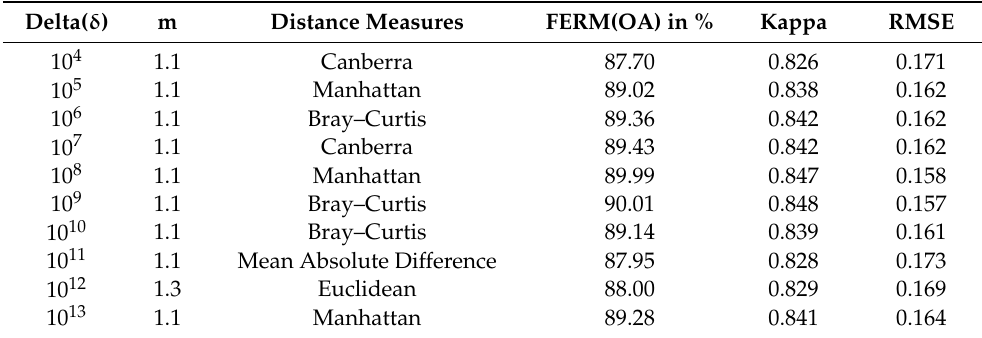
Table 5. Kappa and RMSE determined for the highest overall accuracy of the NC_S classifier by applying different parameters for site 1 (Haridwar).